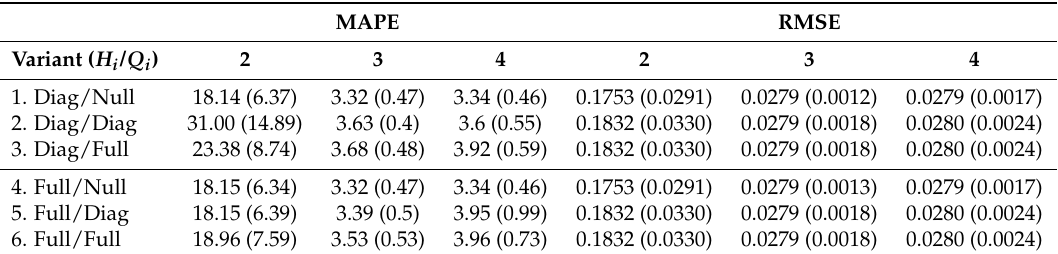
Table 4. MAPE and RMSE for the forecasting in function of the number of principal components for the simulated signal and for the six model variants. Mean values are obtained from four one-step-ahead predictions. Standard deviations are reported in parentheses.